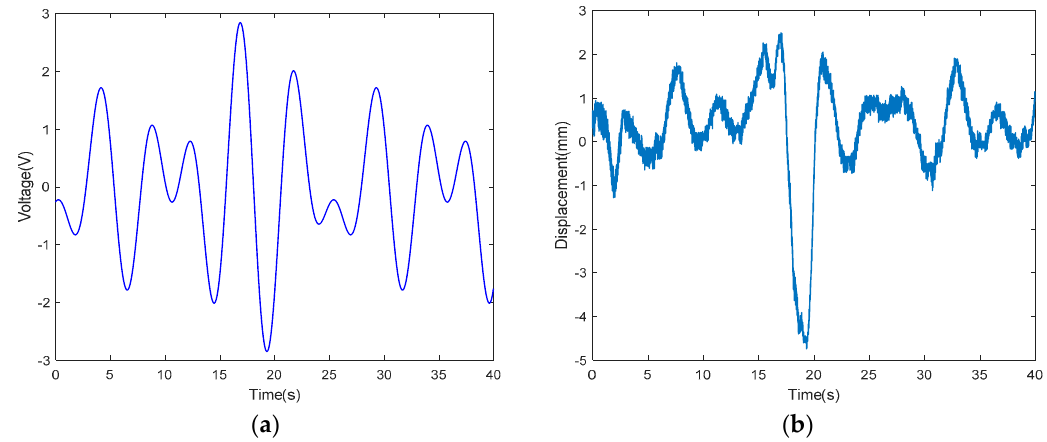
Figure 29. The displacement of the tip by the Random sinusoidal drive voltage I: ( a ) Figure 30. The displacement of the tip by the Random sinusoidal drive voltage I: ( a ) Random sinusoidal drive voltage I; ( b ) Random sinusoidal tip displacement Random sinusoidal drive voltage I; ( b ) Random sinusoidal tip displacement I.